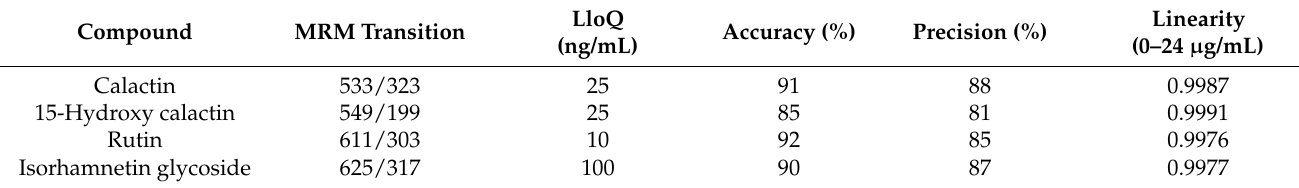
Table 2. Technical and validation parameters of the LC/MS-based method used for the quantization of calactin, 15-hydroxy calactin, rutin, and isorhamnetin